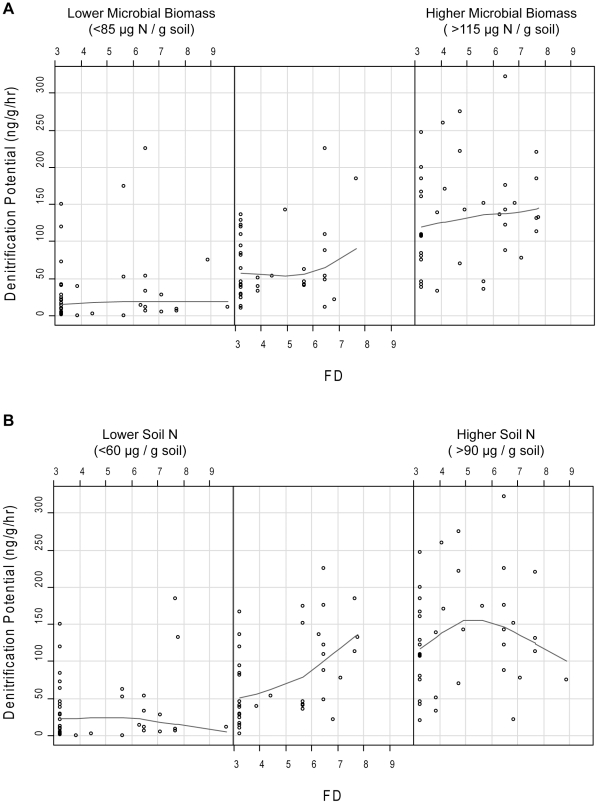
Coplots of denitrification potential versus functional diversity (FD) conditional on the range of (A) soil microbial biomass (µg N g−1 dry soil) and (B) soil inorganic N (µg g−1 dry soil).The lines are lowess (locally-weighted scatterplot smoothing) curves that follow the trends in the data.